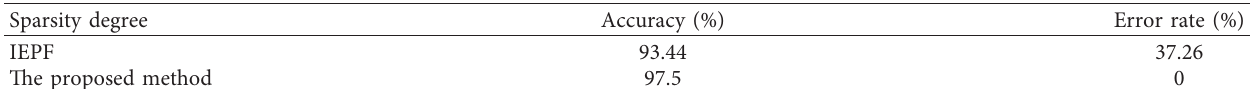
Figure 6: GMapping the drawing effect. (a) Drawing effect of using 30 particles by GMapping. (b) Drawing effect of using 60 particles by GMapping. Table 1: Comparison of line segment feature extraction